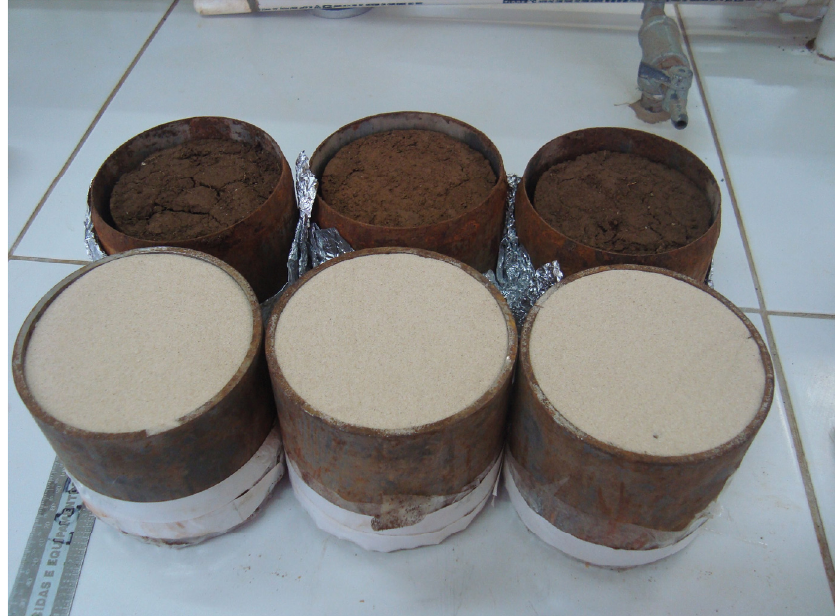
Figure 1. Soil samples with undisturbed structure.